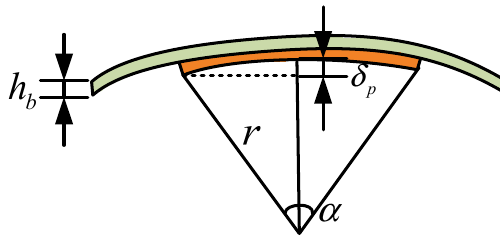
Figure 5. MFC deformation calculation diagram.